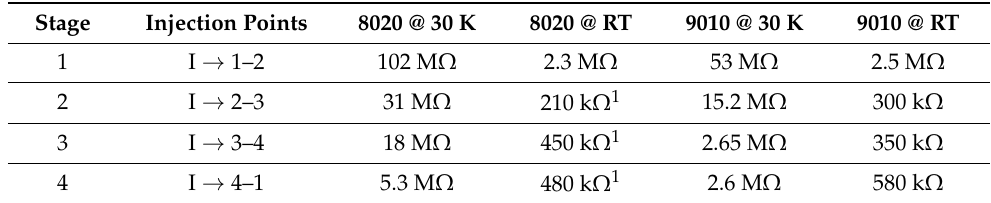
Figure 3. Surface characterization of BD samples: XPS (panels ( a – c ) and Raman (panel ( d ))). Table 1. Resistance values measured at the highest (300 K) and the lowest (30 K) temperature during the four stages of current